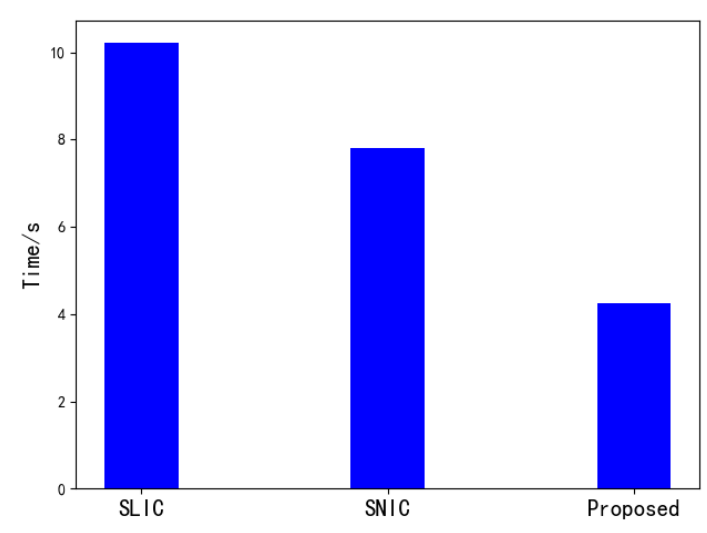
Figure 7. Comparision of segmentation